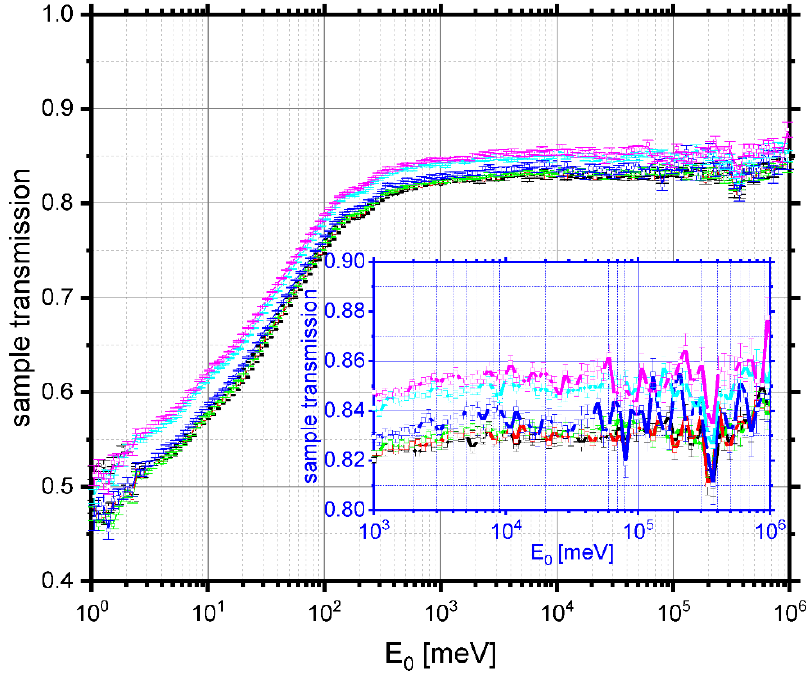
Figure 6. Neutron transmission curves, recorded in a wide range of incident neutron energies, be- tween 1 meV and 1000 eV and at a set of temperatures in the range of − 20 ° C to 80 ° C for the sample of rice pasta with the water content 0.1069 g/g d.m. Black, red, green, blue, cyan, and magenta traces with data points and error bars show data recorded at − 20, 0, 20, 40, 60, and 80 ° C. Inset: the close- up of the transmission in the epithermal neutron range defining the scattering power of the sample as a function of temperature.